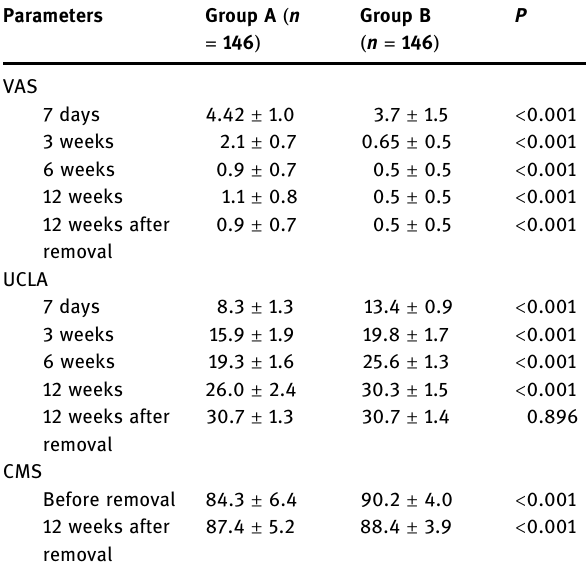
Table 4: Matched patient ’ s postoperative assessment between two groups Parameters